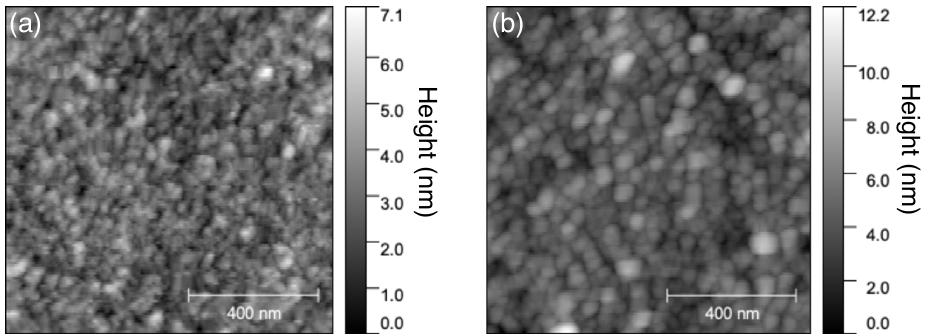
Figure 5. AFM image of ( a ) bare Au substrate and ( b ) Au substrate with BT. The scan area was set at 1 µ m × 1 µ